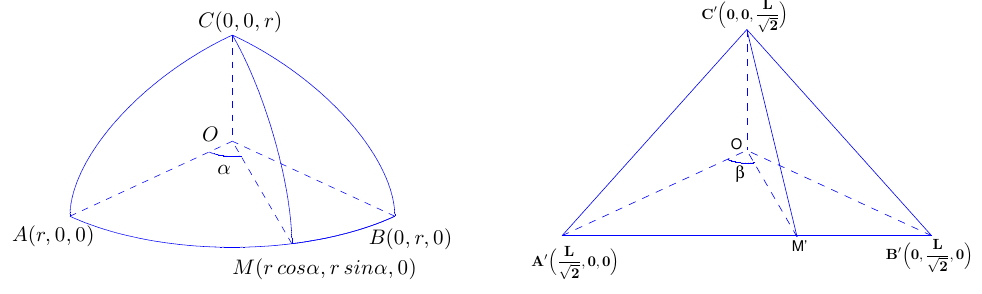
Figure 2. The spherical region OAMC and its image OA (cid:48) M (cid:48) C (cid:48) =